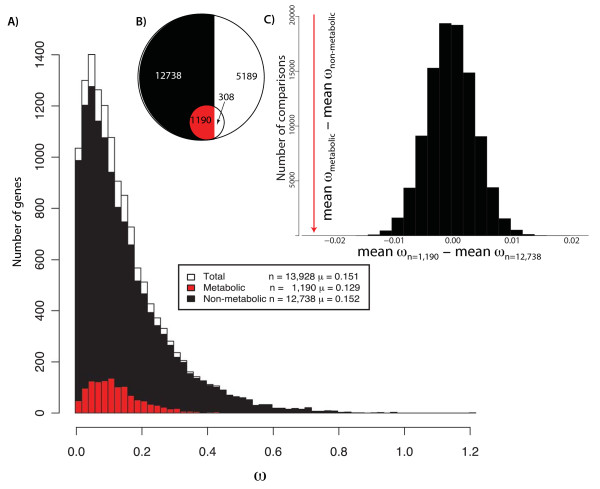
Human metabolic genes are under greater selective constraint than other orthologous genes. A) The distribution ω for metabolic genes (red, nm = 1,190), non-metabolic genes (black, no = 12,738), and the total set of orthologs (white, nt = nm+no= 13,922). The x-axis gives ω: the ratio of non-synonymous to synonymous substitutions per site (i.e., our proxy for selective constraint, see main text). The y-axis is the number of genes with a given ω value for each gene set. We can reject the hypothesis that the median of metabolic genes is not significantly smaller than the median of non-metabolic genes (P = 0.035; Mann-Whitney U-test). B) The white portion of the circle graph shows the relative proportions of genes for which we cannot identify orthologs for the metabolic and non-metabolic genes (red and black, respectively). These proportions are significantly different (χ2 = 11.98, P < 0.001). C) After taking samples of size n = 1,190 and n = 12,738 and calculating the difference in mean ω, 100,000 times, we found no case in which the absolute difference in mean values was as high as the observed difference in mean ω for metabolic and non-metabolic genes (P < 10-5).